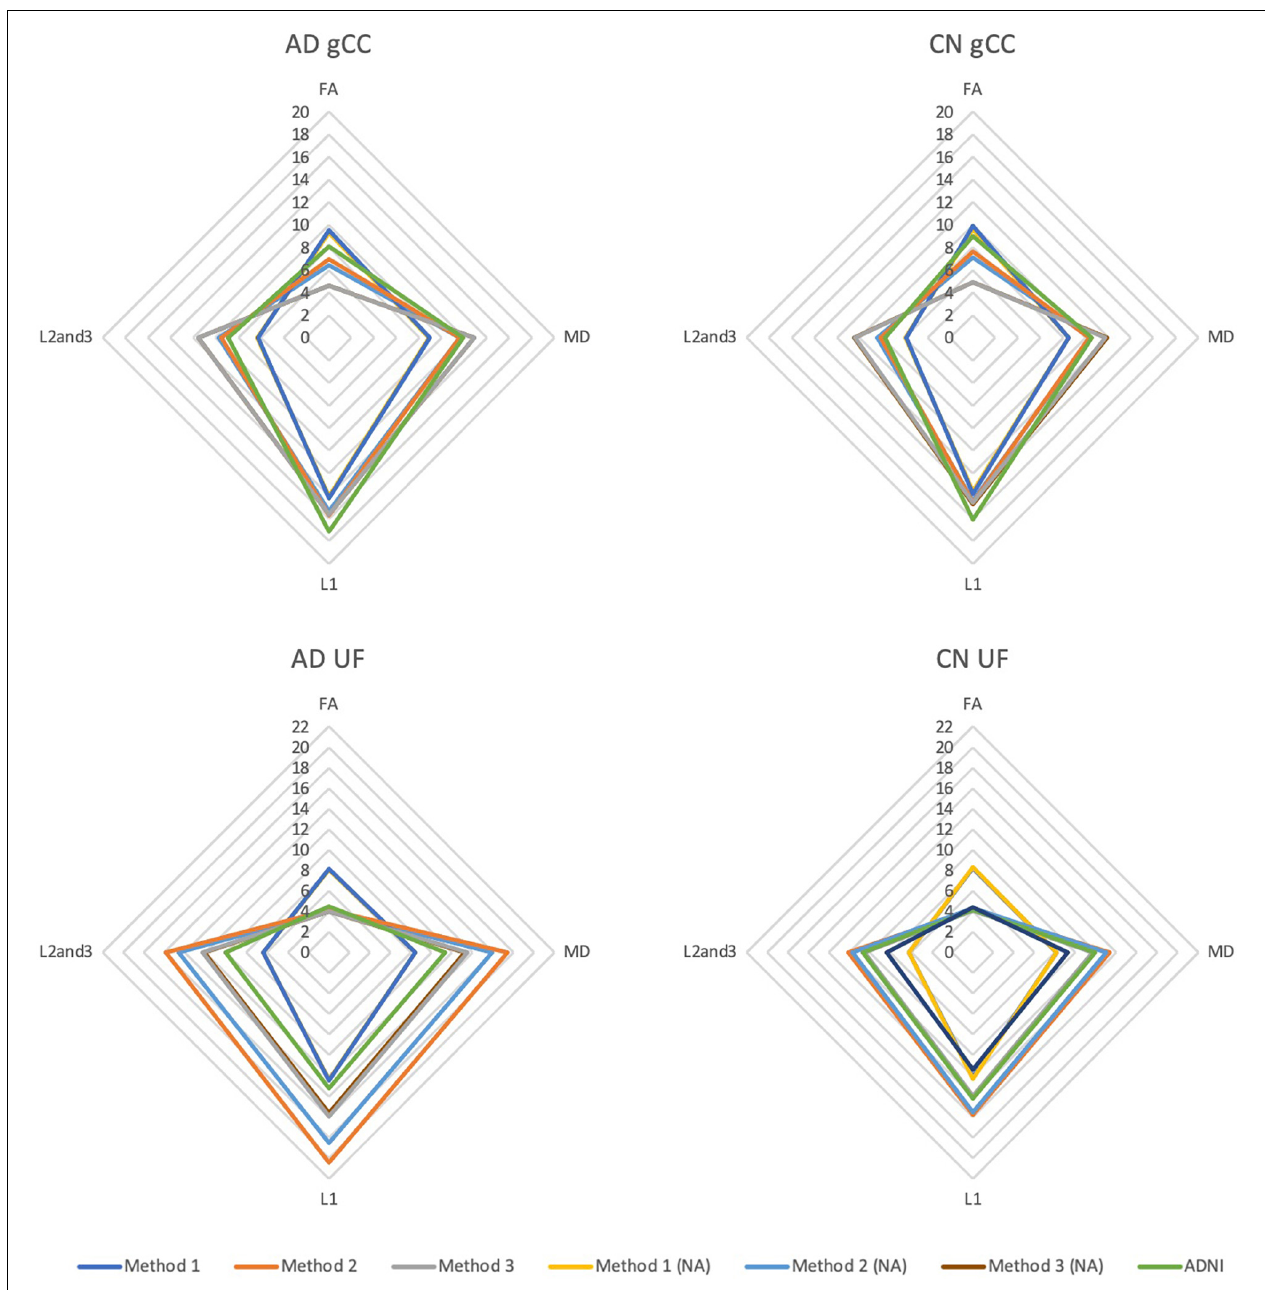
FIGURE 5 | DTI radar graph profiles for comparison of methods with and without ACPC alignment and co-registration in Alzheimer’s disease (AD) and cognitively normal (CN) cohorts. DTI metrics from the ADNI data archive are included for reference. FA values are presented as x20 for illustration; MD, L1, L2, and 3 values are presented as × 10 4 . gCC, genu of the corpus callosum; UF, uncinate fasciculus; NA, no ACPC